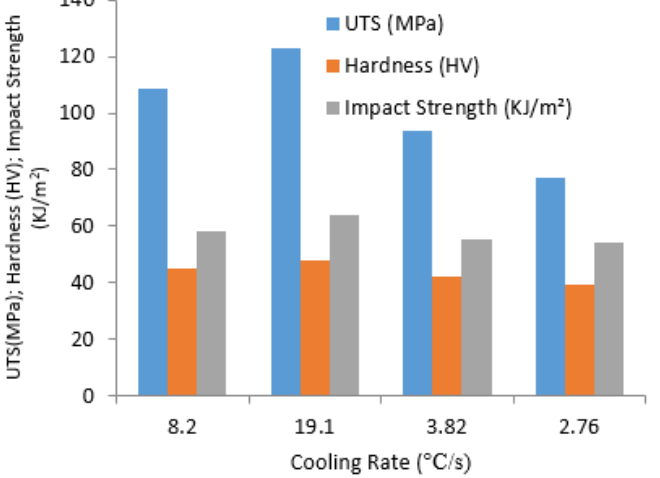
Figure 4: Variation in ultimate tensile strength UTS, Hardness and Impact strength with cooling rate.